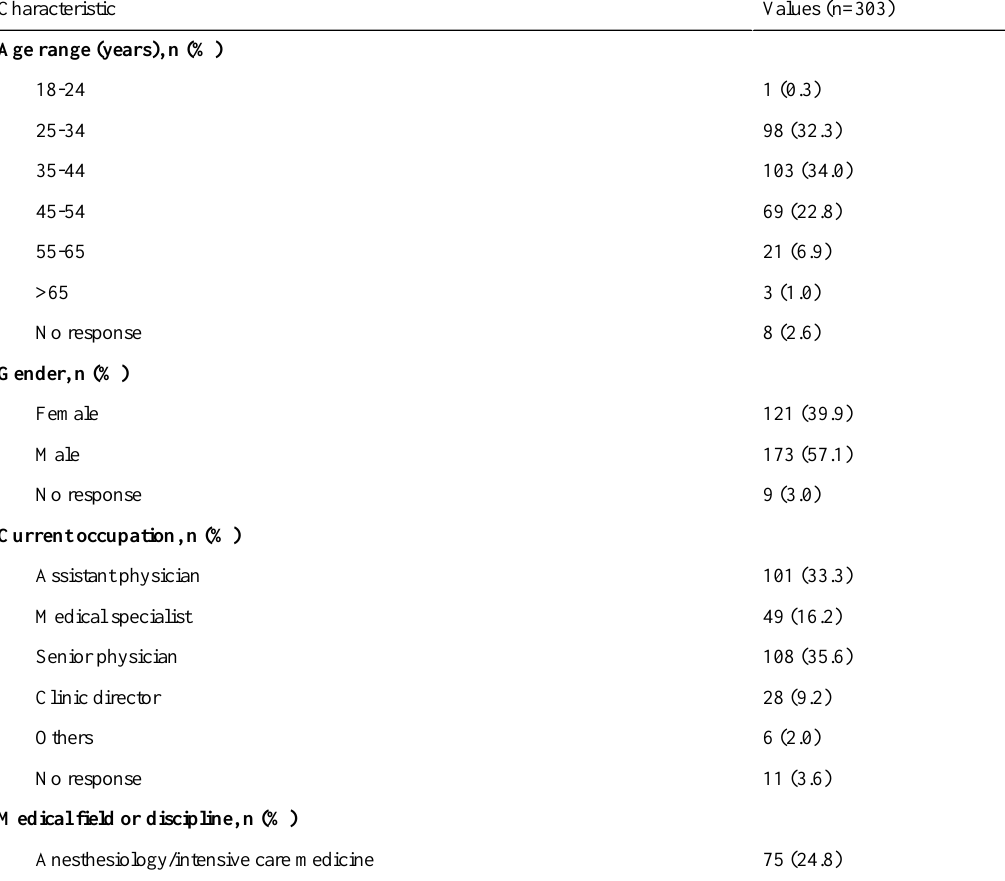
Table 1. Demographic and professional characteristics.